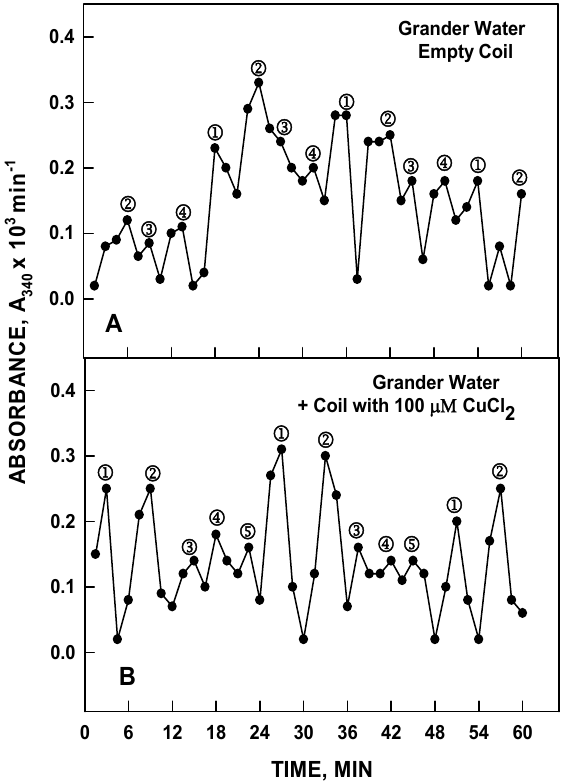
Figure 13. The reverse experiment gave the reverse result. With HPLC water (4 maxima, 18 min period) ( A ) placed over the coil now filled with 100 µM CuCl 2 , the result was that the HPLC water now oscillated with the 5 peak 24 min period characteristic of the 100 µM CuCl 2 ( B